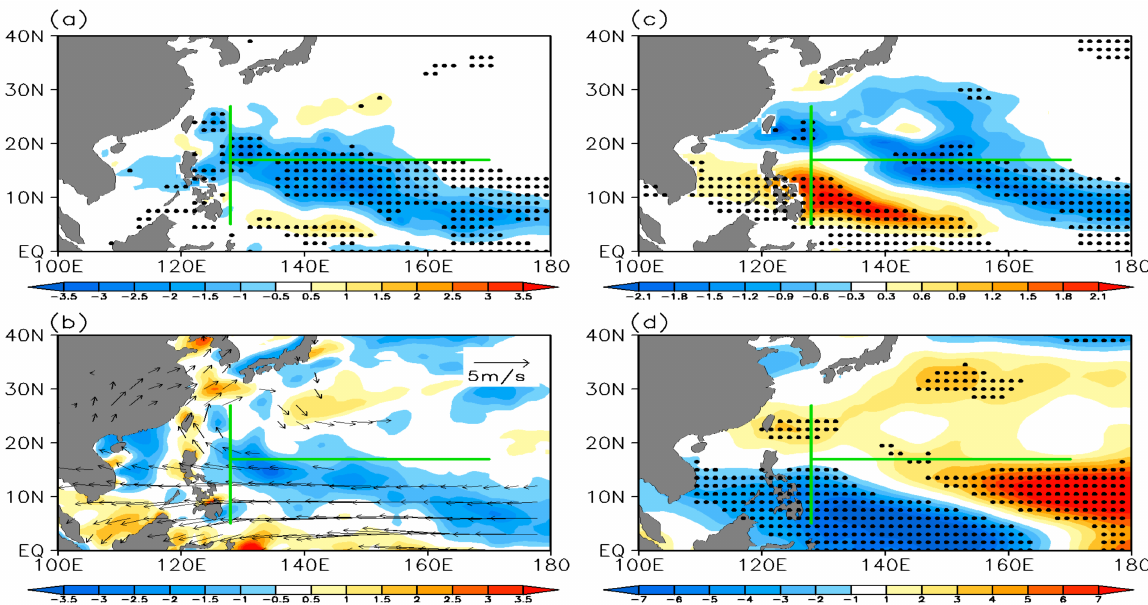
Figure 5. The difference in ( a ) GPI changes induced by VOR , ( b ) 850 hPa relative vorticity (shading) and wind fields (vectors), ( c ) GPI changes induced by VWS , and ( d ) the vertical wind shear between the positive and negative phases of PC2. The dots mark regions where the differences are significant at the 95% confidence level. For the changes in the wind fields at 850 hPa in ( b ), only areas where the differences are statistically significant at the 95% confidence level are